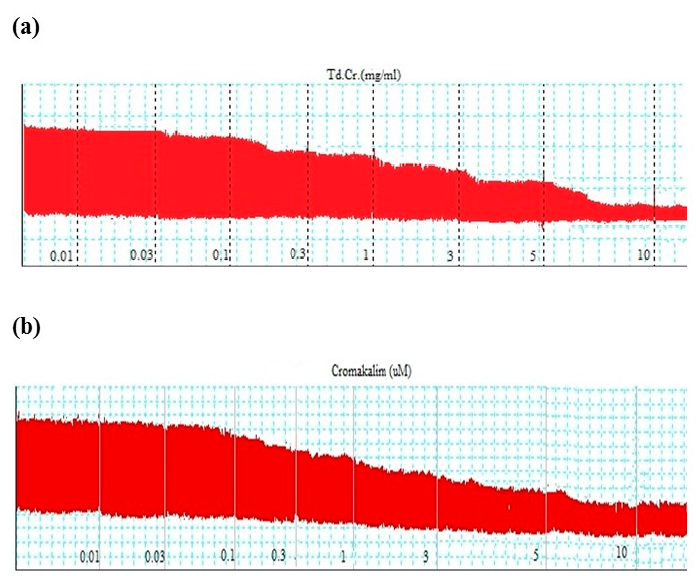
Figure 11. Tracings indicating the effect of ( a ) TdCr and ( b ) cromakalim on spontaneous contractions of paired atrial preparation of a rabbit. Biomolecules 2019 , 9 , 722